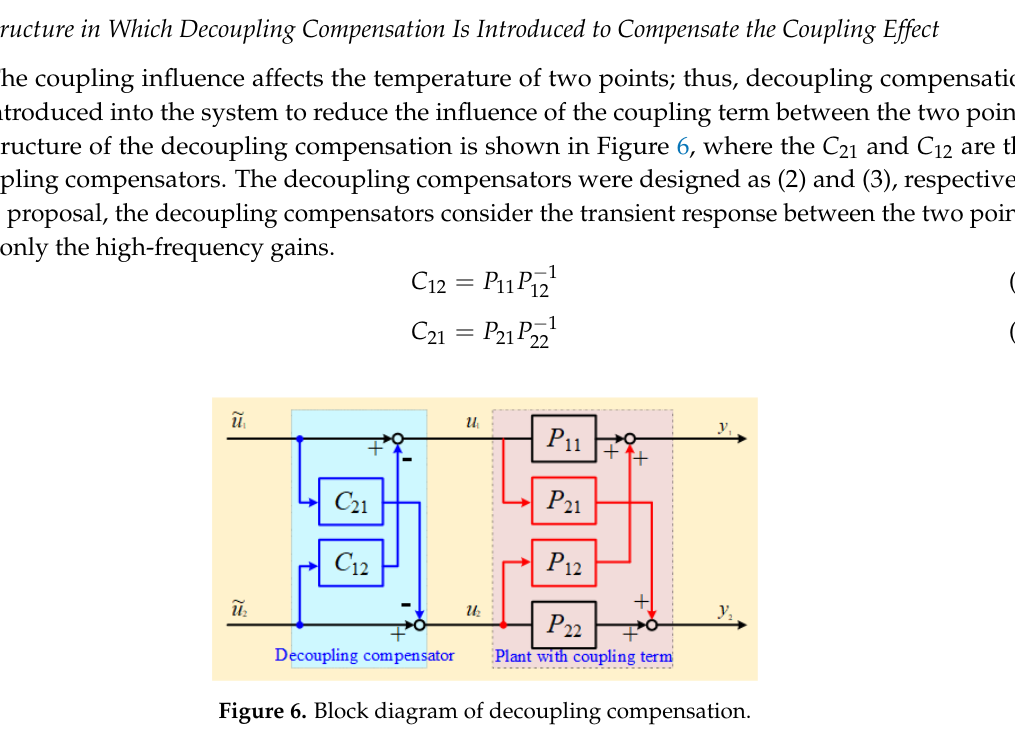
Figure 5. Block diagram of Smith predictor compensation.